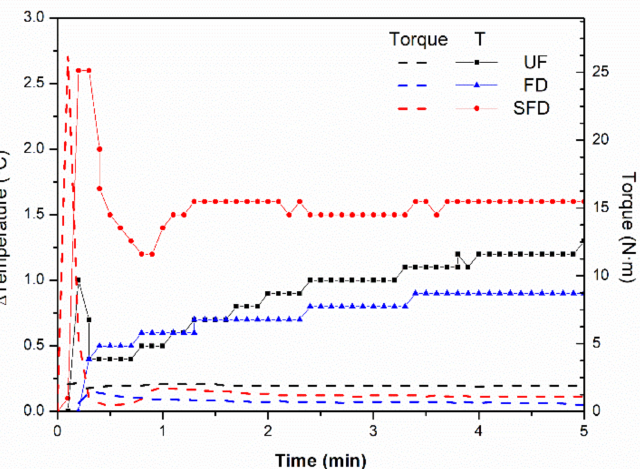
Figure 1. Torque and temperature profile developed within the mixer cavity during the mixing stage for porcine plasma protein-glycerol blends using UF, FD, and SFD protein